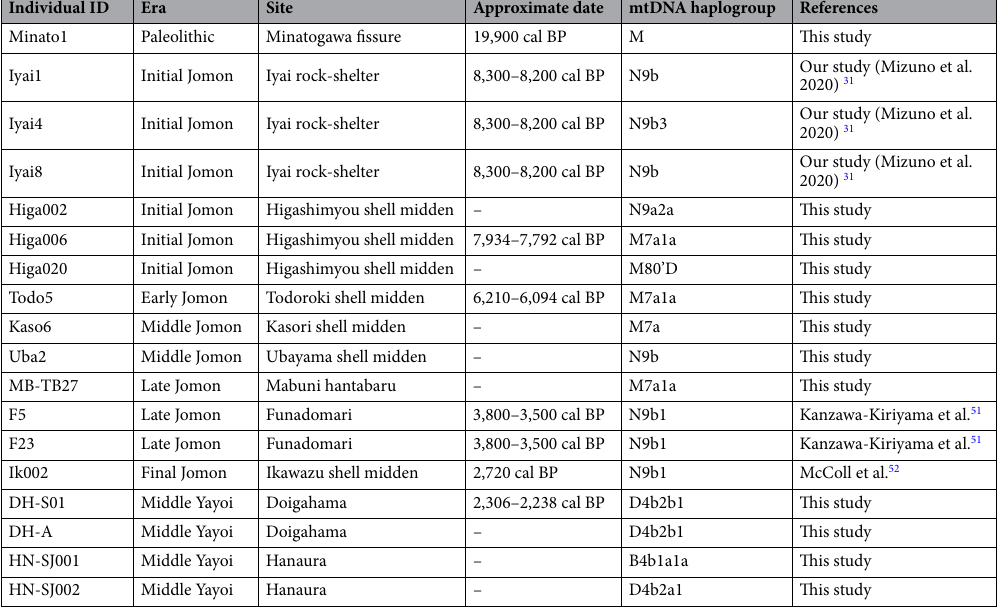
Table 1. Late Pleistocene and Holocene human remains of the Japanese Archipelago used in this